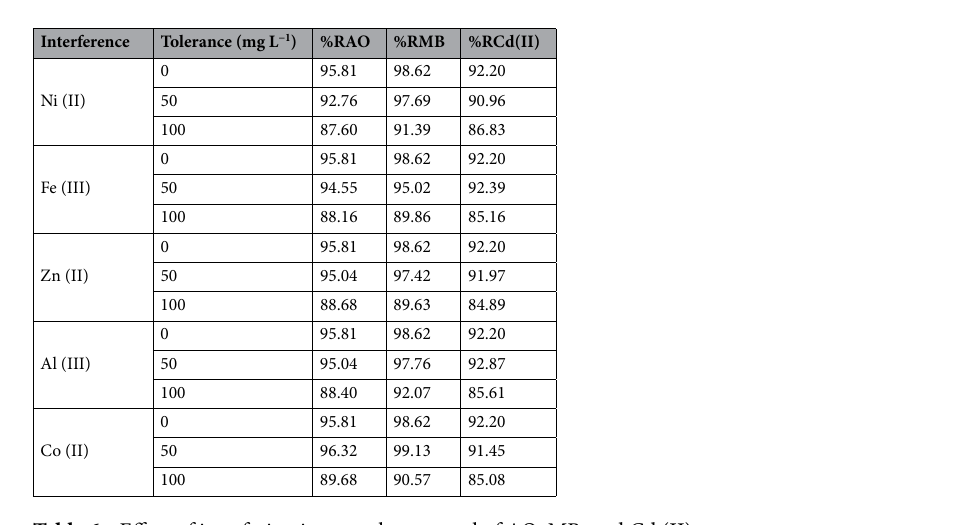
Table 5. Removal of AO, MB, and Cd (II) in real samples.